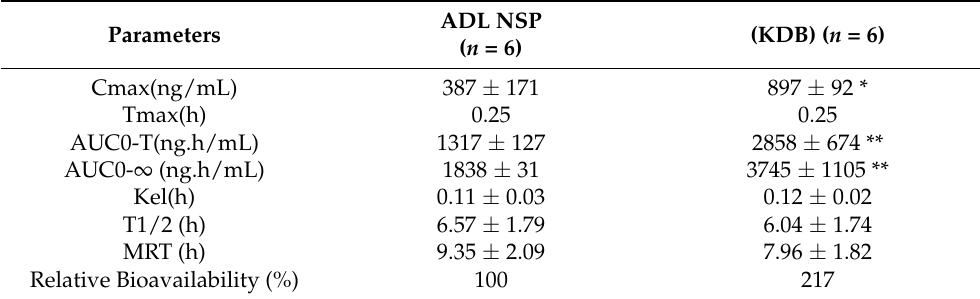
Table 2. Pharmacokinetic parameters of pure ADL and ternary kneaded ADL/β-CD with 1% poloxamer 188 (KDB). Parameters